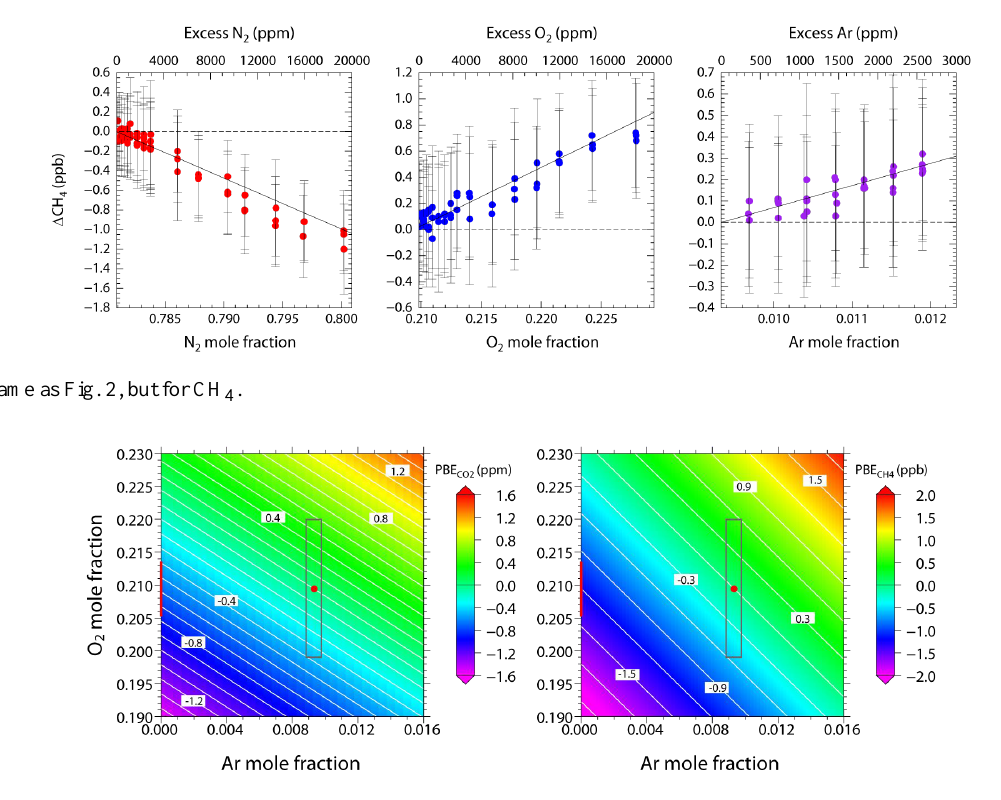
Fig. 4. Estimated pressure-broadening effects resulting from variations in matrix gas composition as a function of O 2 and Ar mole fraction for CO 2 measurements at 400ppm (left) and for CH 4 measurements at 2000ppb (right). The red circles denote ambient levels of O 2 and Ar. The gray solid rectangle denotes the ± 5% range of O 2 and Ar relative to their ambient levels. The thick red line on the y -axis indicates O 2 variation within ± 2% from its ambient level. The error associated with these estimations is negligible (less than 1% of the estimated values).